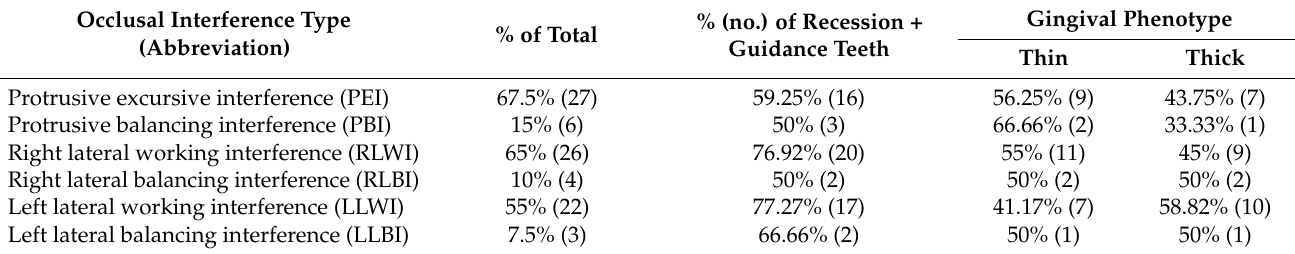
Table 3. Data distribution of interference type associated with gingival recession.